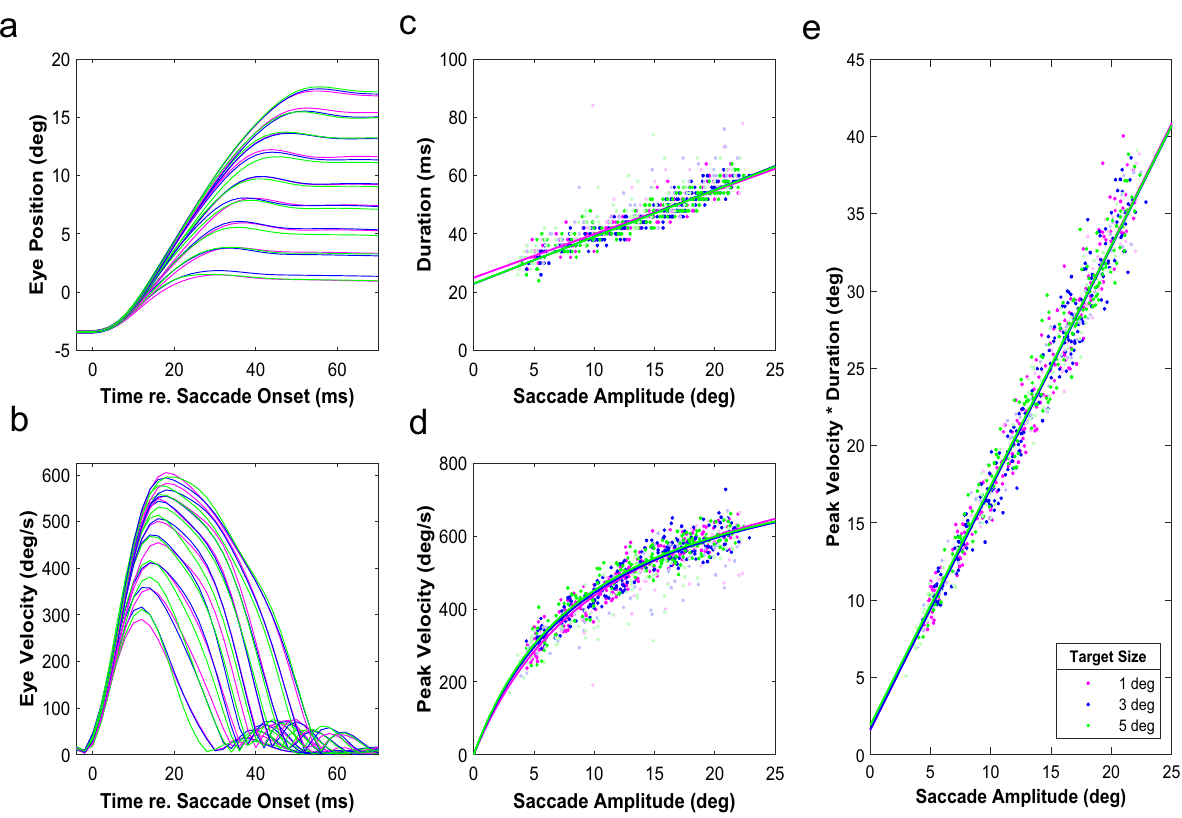
Figure 3. Main sequence. ( a , b ) Average eye position ( a ) and eye velocity ( b ) traces for saccades to each of the nine different target locations, stratified by target size (color code). ( c , d ) The main sequence relationships of duration ( c ) and peak velocity ( d ) against saccade amplitude for rightward saccades of the participant’s right eye. The faded dots represent the late saccades. Solid lines are fit to the data for saccades with latencies < 250 ms and a gain ranging between 0.9 and 1.1 (i.e., a subset of the brighter dots). ( e ) The Peak velocity*Duration is the same for early and late